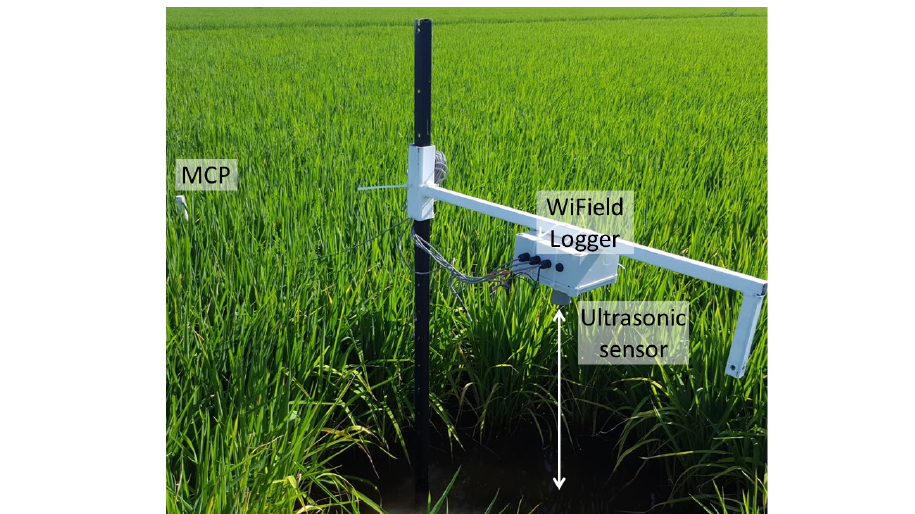
Figure 2. Photograph of a WiField data logger installed in a rice field with ultrasonic water level sensor, temperature sensors and MCP